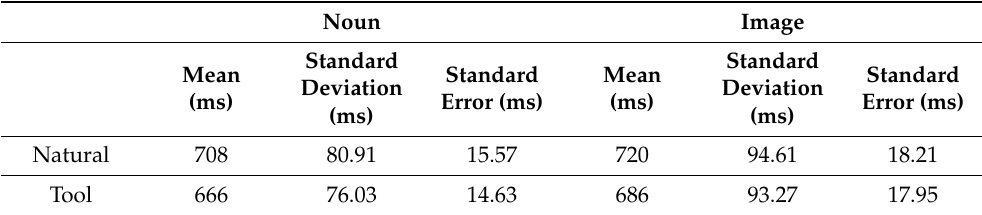
Table 1. Descriptive statistic of behavioral study (Experiment